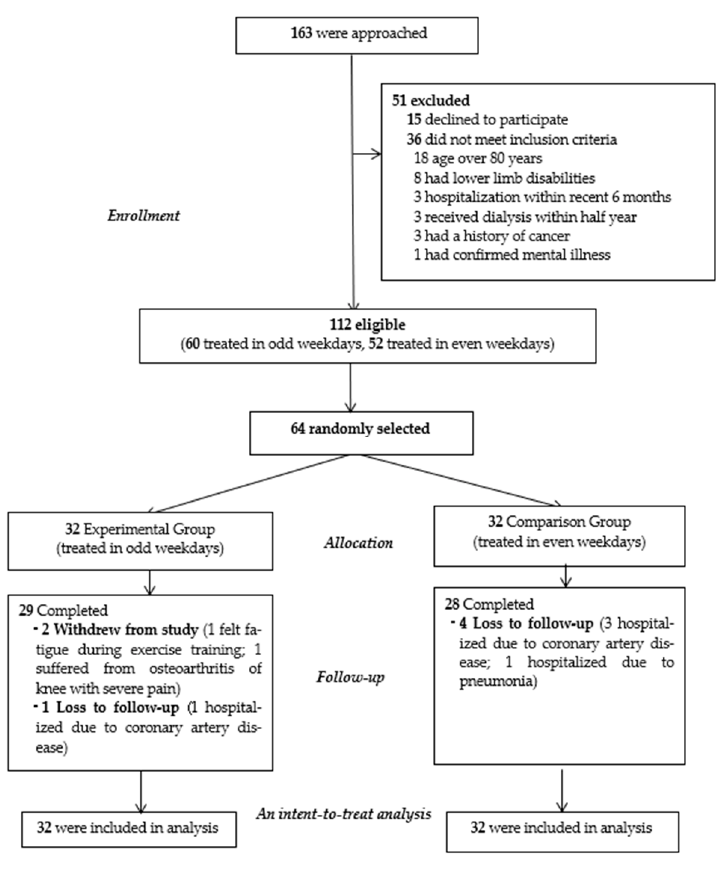
Figure 1. CONSORT Diagram of Participants’ Flow Through the Trial. Table 1. Comparisons of demographics and comorbidity characteristics between groups.